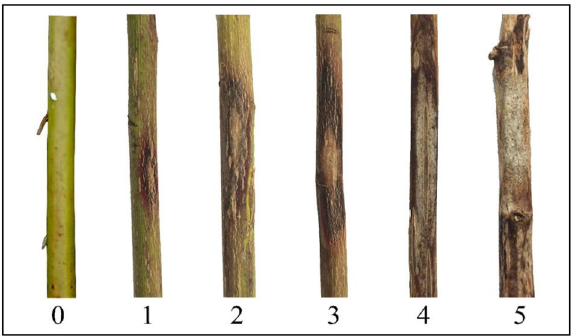
Figure 14. The severity levels of stem necrotic lesions were visually estimated from the stem